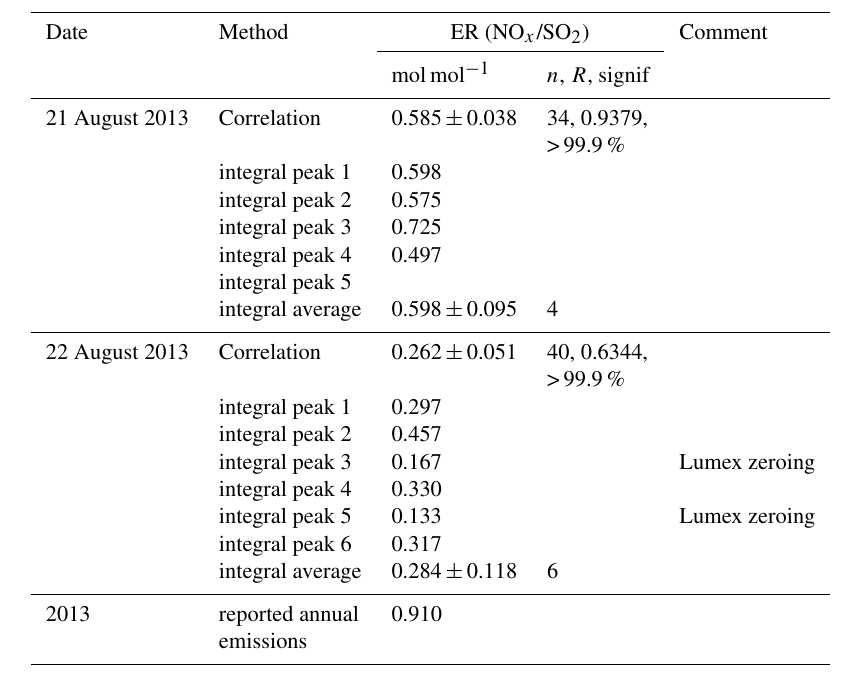
Table 4. NO x / SO 2 enhancement ratios (ERs). Correlation method: 10s average NO x mixing ratios correlated with 10s average SO 2 mixing ratios above 10ppb with uncertainties set to 1ppb for NO x and 0.5ppb for SO 2 . Integral method: 1s NO x and 1s SO 2 signals integrated over the duration of the individual plume intersection. Background mixing ratios for SO 2 and NO x are 0.83 and 1.78ppb, respectively, for 21 August and 0.66 and 0.45ppb, respectively for 22 August.